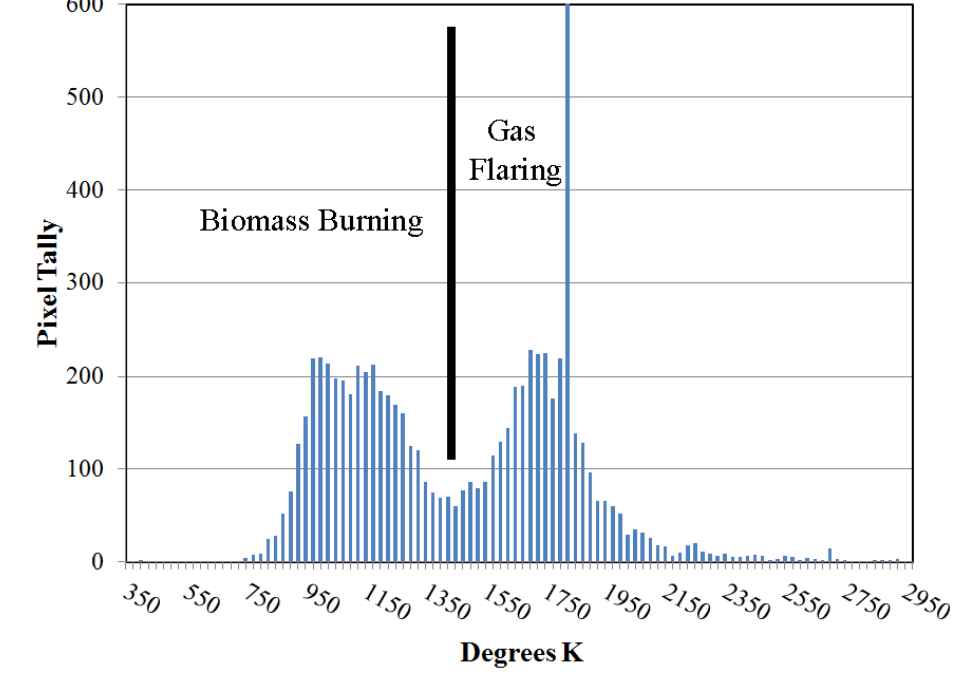
Figure 7. Histogram of temperature results from 3 July 2013. There is a spike in the histogram bin covering 1810 K due to the assumption that detections made with M10 and DNB only have peak radiant emission in the M10 spectral